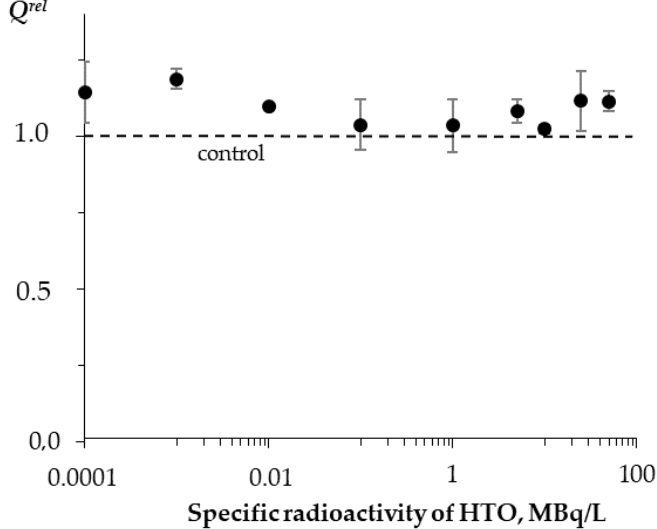
Figure 5. Relative activity of bacterial luciferase, Q rel , vs. specific radioactivity of HTO at 5 min exposure.